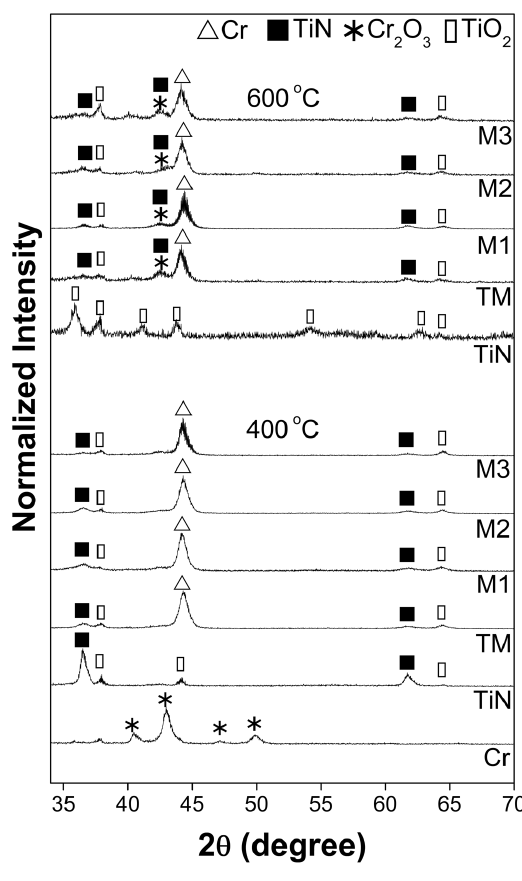
Figure 7. GAXRD patterns of coatings oxidized at 400 °C and 600 °C.